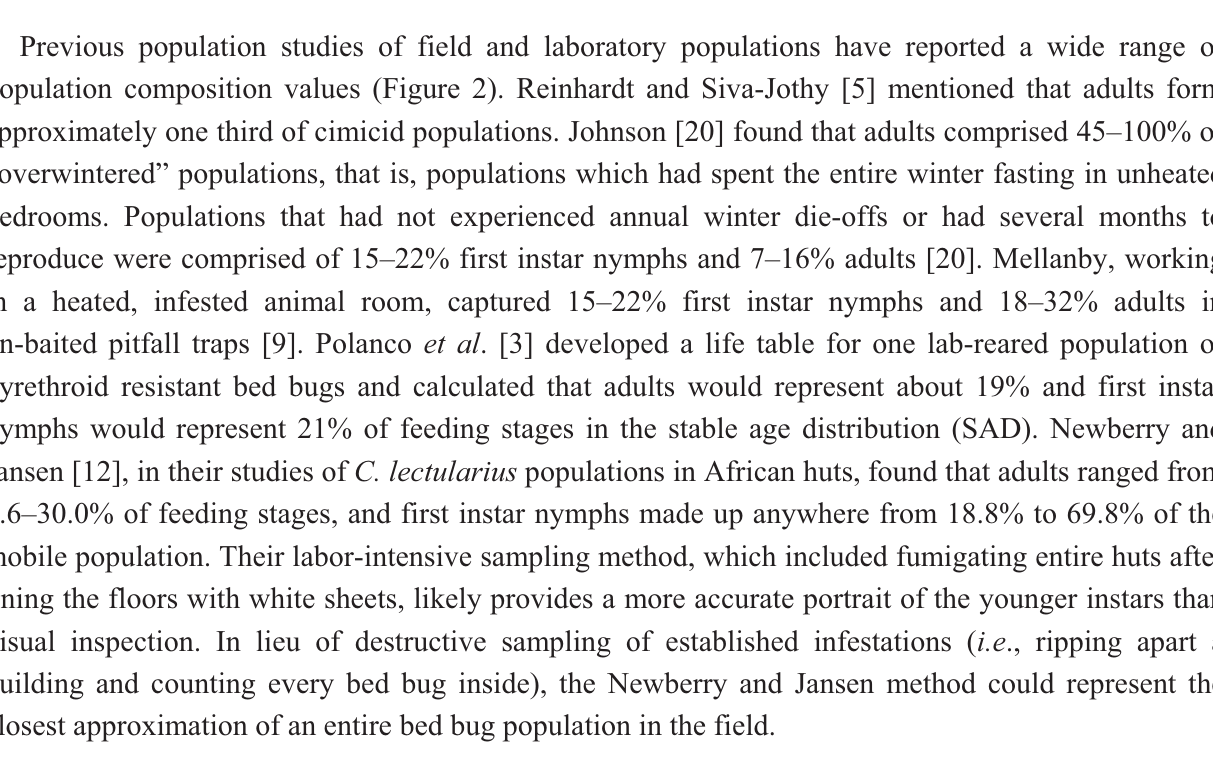
Figure 2. Proportion of feeding stages consisting of first instar nymphs (orange) and adults (red) in bed bug populations described in this study and in select studies from the